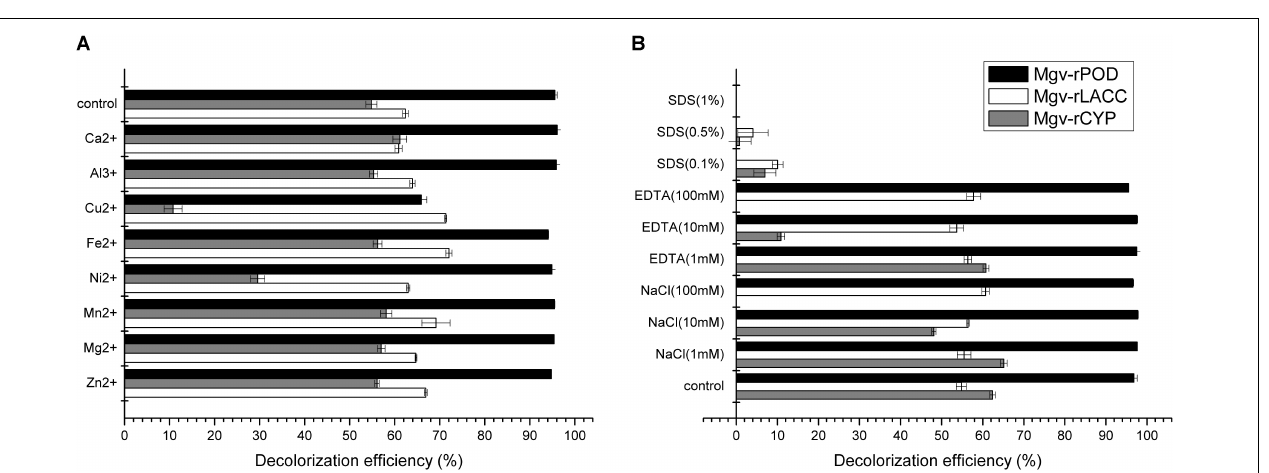
Desmethyl-MG (m/z 315), didesmethyl-MG (m/z 302), hydroxyl(didesmethyl)-MG (m/z 318), tetradesmethyl-LMG (m/z 274), hydroxyl-MG (m/z 346), Michler’s ketone (m/z